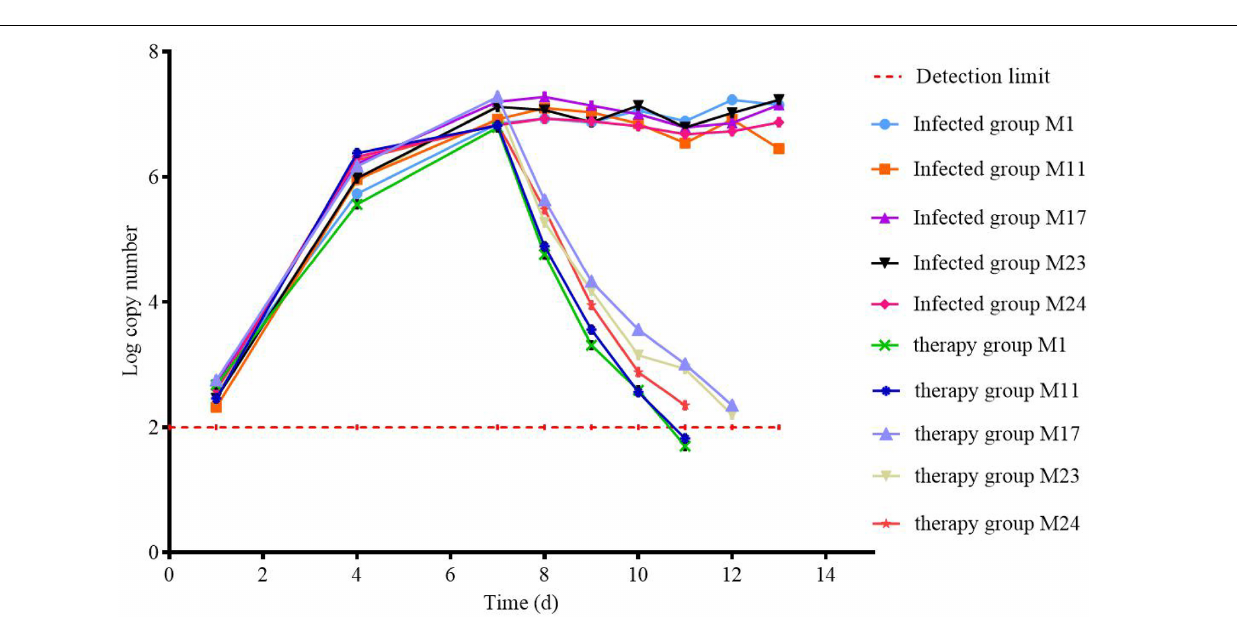
FIGURE 9 | Changes in the amount of MG in chickens during clinical